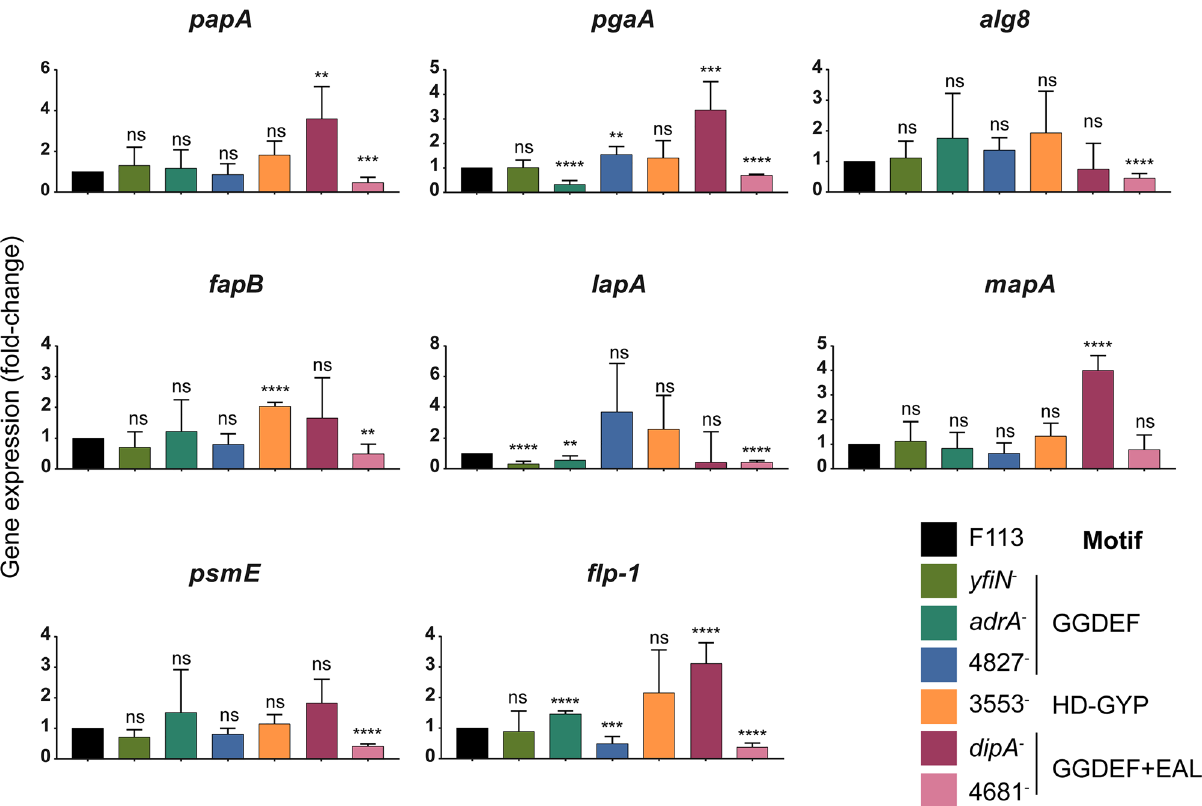
Figure 3. Local DGCs and PDEs are involved in the regulation of ECM-related genes. qRT-PCR analysis of selected extracellular matrix-related genes in stationary phase. Gene expression from mutants affected in the synthesis of proteins with GGDEF motifs ( yfiN - , adrA - , and PSF113_4827), HD-GYP domain (PSF113_3553), or containing both GGDEF and EAL motifs ( dipA - and PSF113_4681) was normalized to rpoZ and relativized to the wild-type strain. Averages and SD from two biological replicates with three technical replicas are represented. Significant differences in gene expression were determined with multiple t-tests with